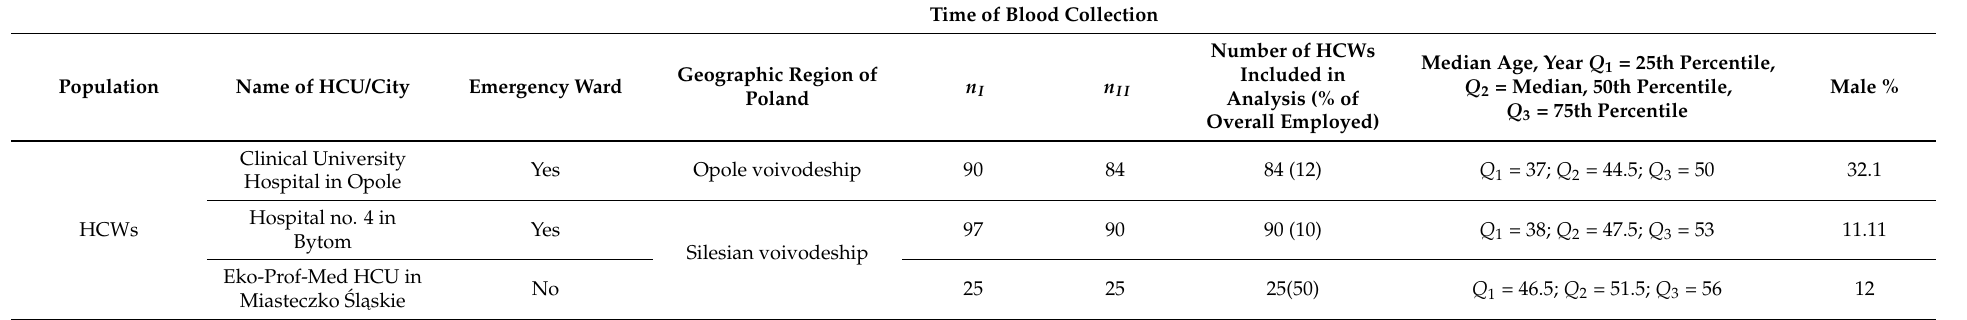
Table 1. Demographic characteristics of Healthcare Units (HCUs) included in the